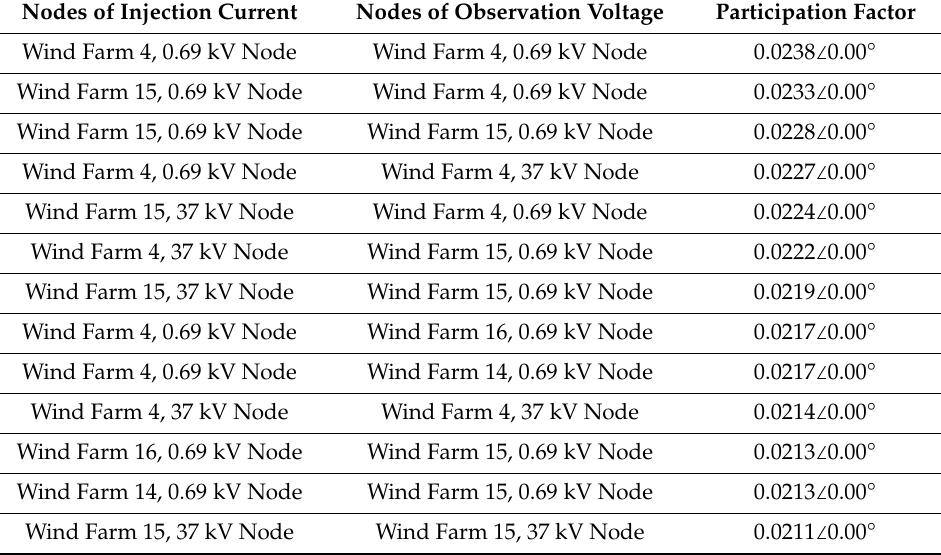
Figure 5 indicates that the phases of all nodal voltages are similar, which means the 77.1 Hz